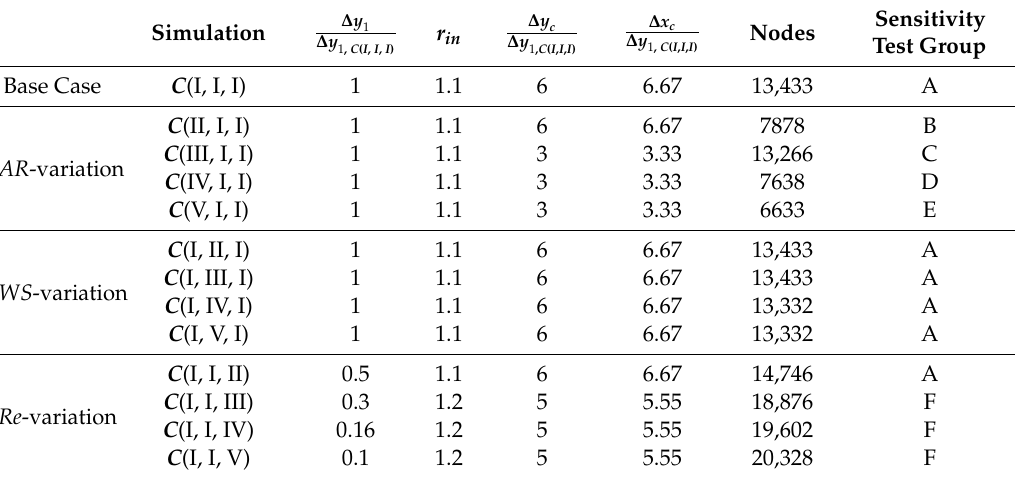
Figure 2. Computational grid. The grid shown here is used for 𝑪 (I, V, I), but it is indicative of all other grids used in the study. Layer height inflation applied on the top and bottom plate is shown on the right. Table 2. Details of gridding